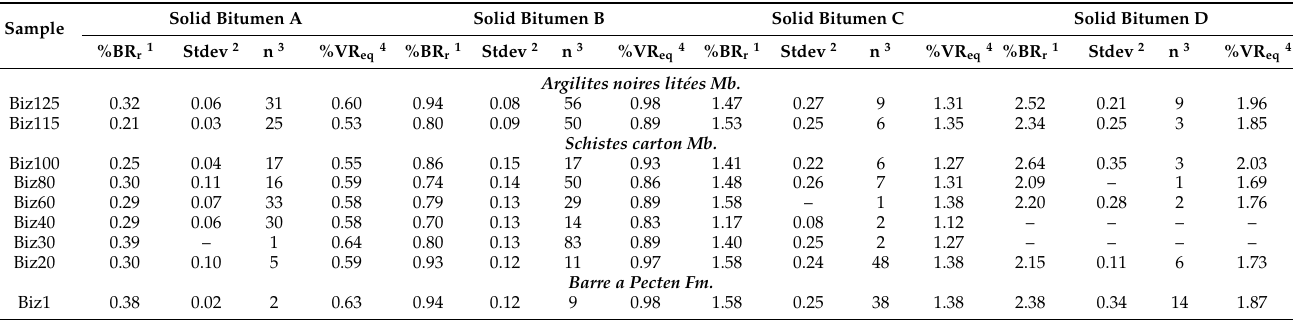
Table 2. Mean random reflectance of solid bitumen.